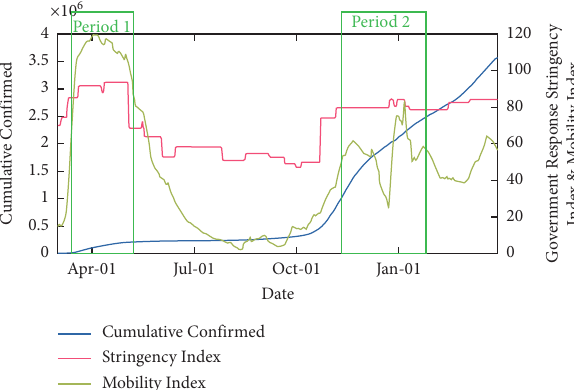
Figure 6: Italy cumulative confirmed cases, stringency index, and mobility index (March 1, 2020–March 31,